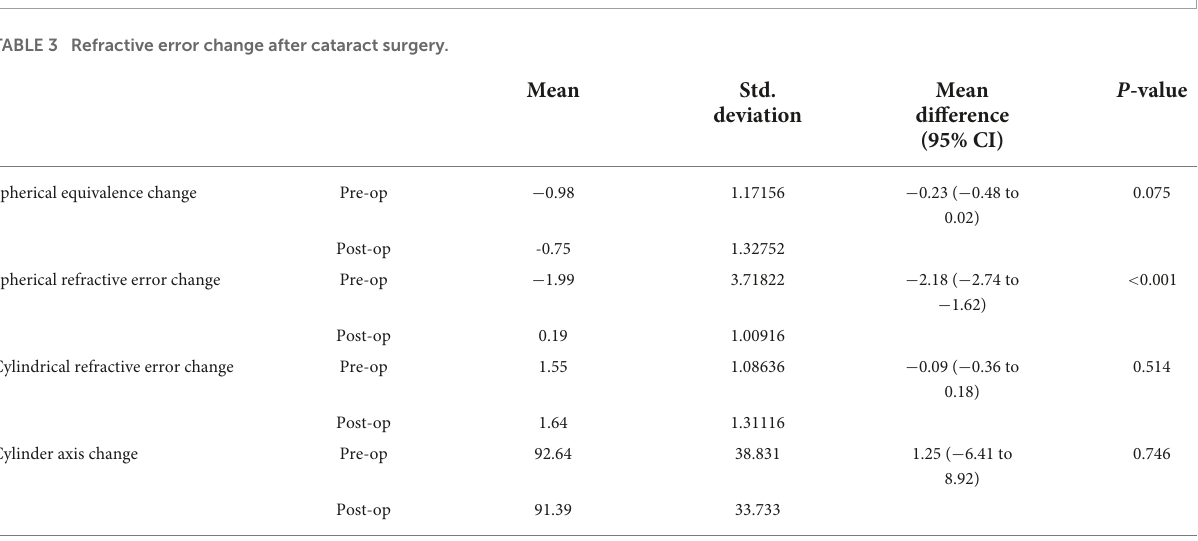
TABLE 3 Refractive error change after cataract surgery.